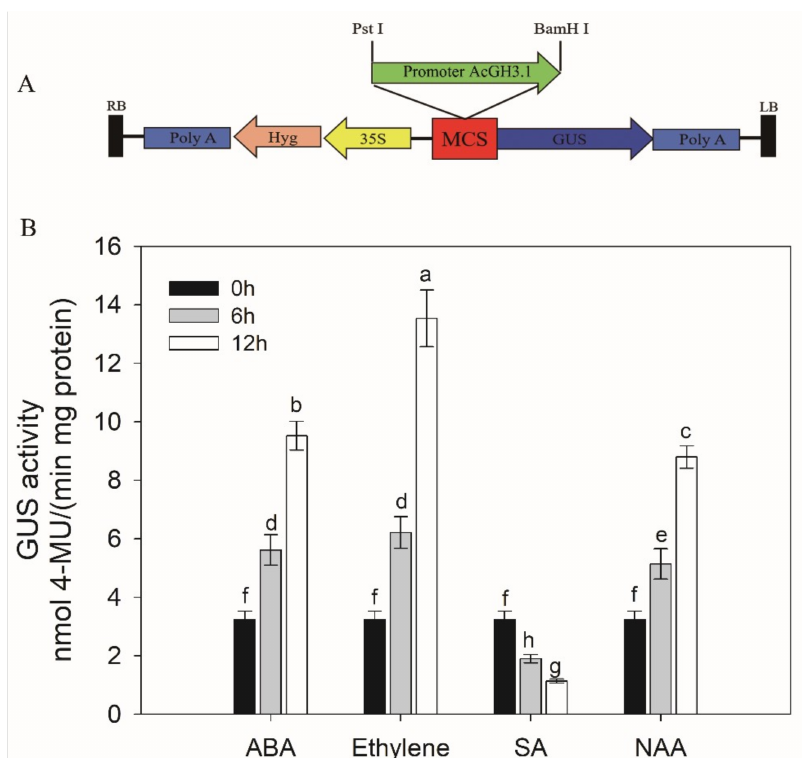
Figure 5. ( A ) Schematic representation of AcGH3.1 promoter cloned in pCAMBIA1391 vector (promoter-less vector) at Pst I and BamH I sites for measuring GUS activity and field-infiltration; ( B ) Comparison of GUS activity determined in protein extracts (in vitro) treated with ABA, ethylene, SA, and NAA. Error bars show the standard error between three replicates performed. Bars with the same letter are not significantly di ff erent at the 0.01